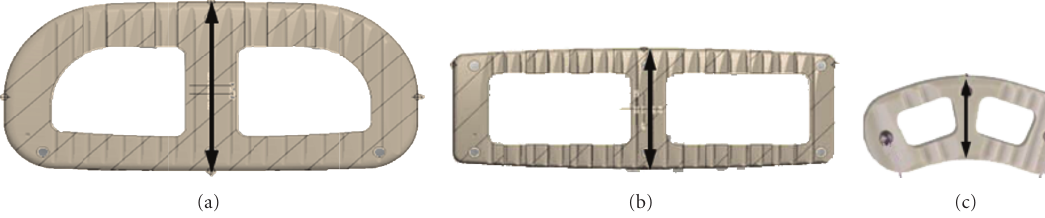
Figure 1: Axial view of cages used in testing (CoRoent, NuVasive, Inc, San Diego, CA): (a) 26 mm XLIF cage, (b) 18 mm XLIF Cage, and (c) 11 mm TLIF cage.